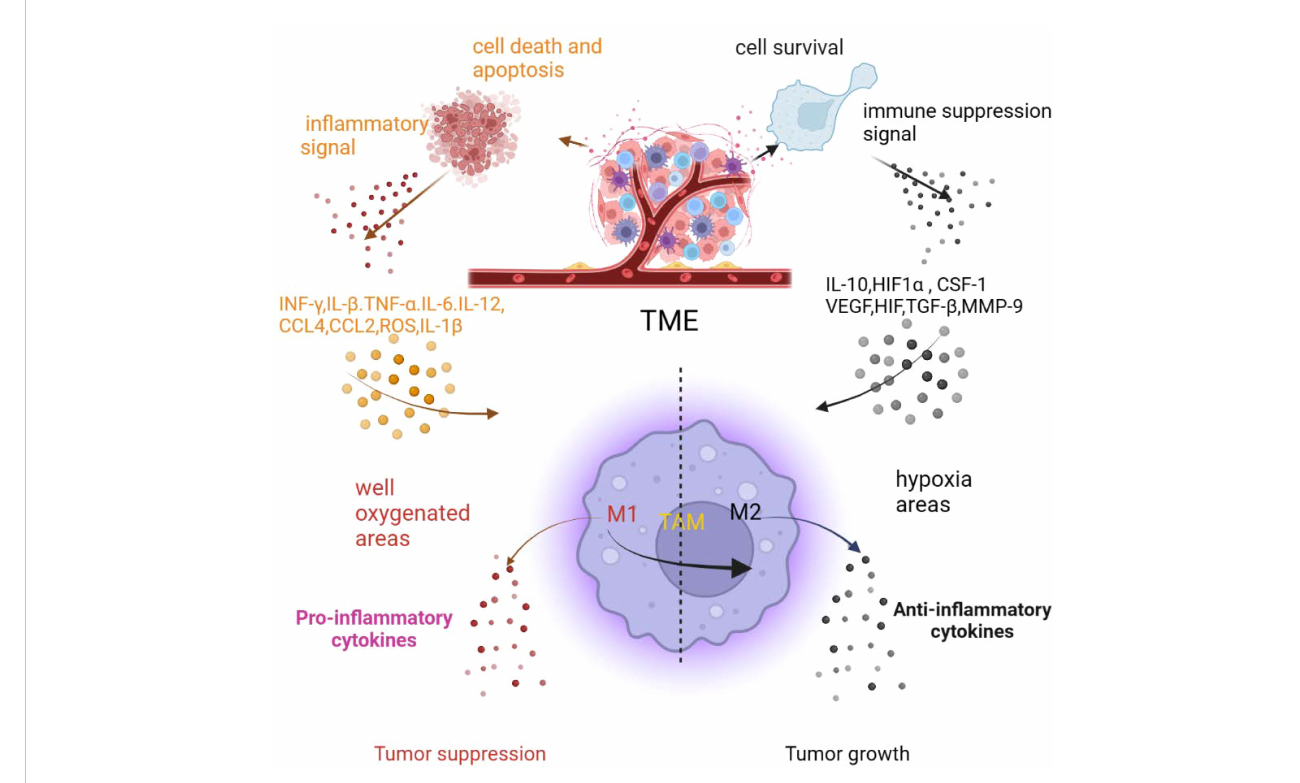
FIGURE 2 The in fl ammatory tumor microenvironment affects macrophage polarization (created in BioRender.com)